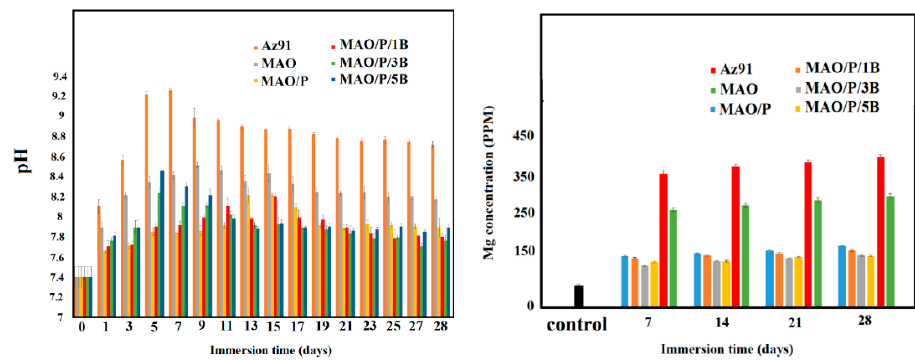
Figure 7. ( a ) pH changes and ( b ) Mg ion concentration of samples as a function of various soaking times.